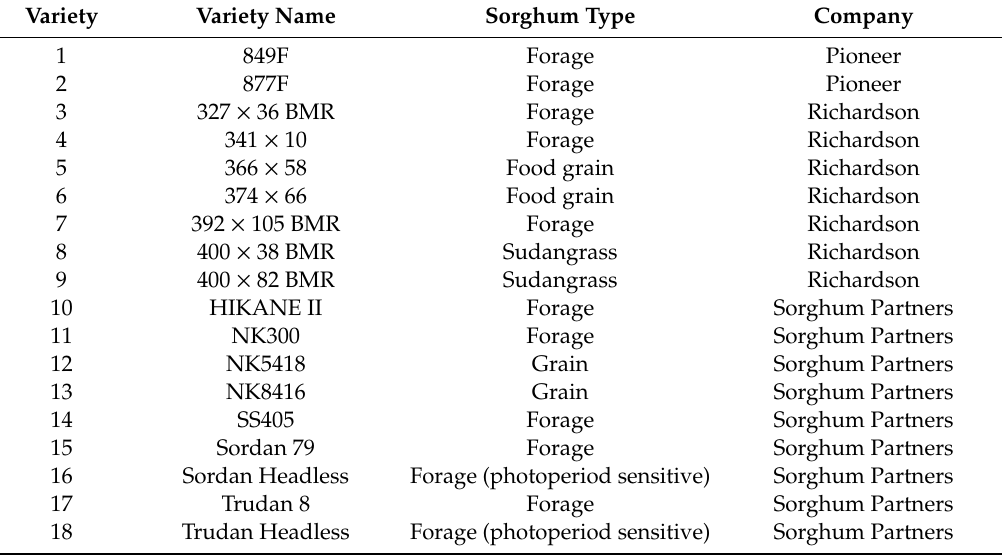
Table A1. Commercial varieties planted in the hybrid calibration panel.